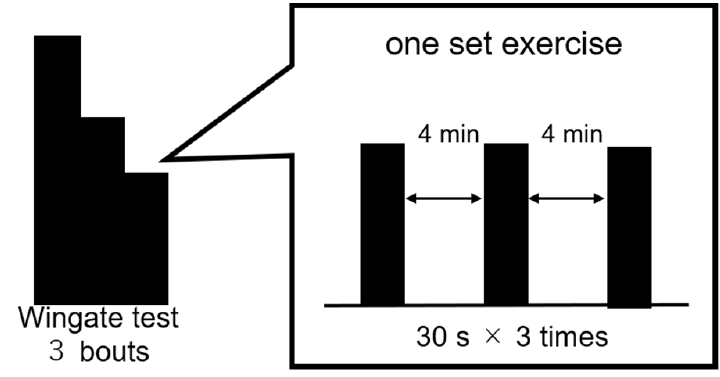
Figure 2. Wingate